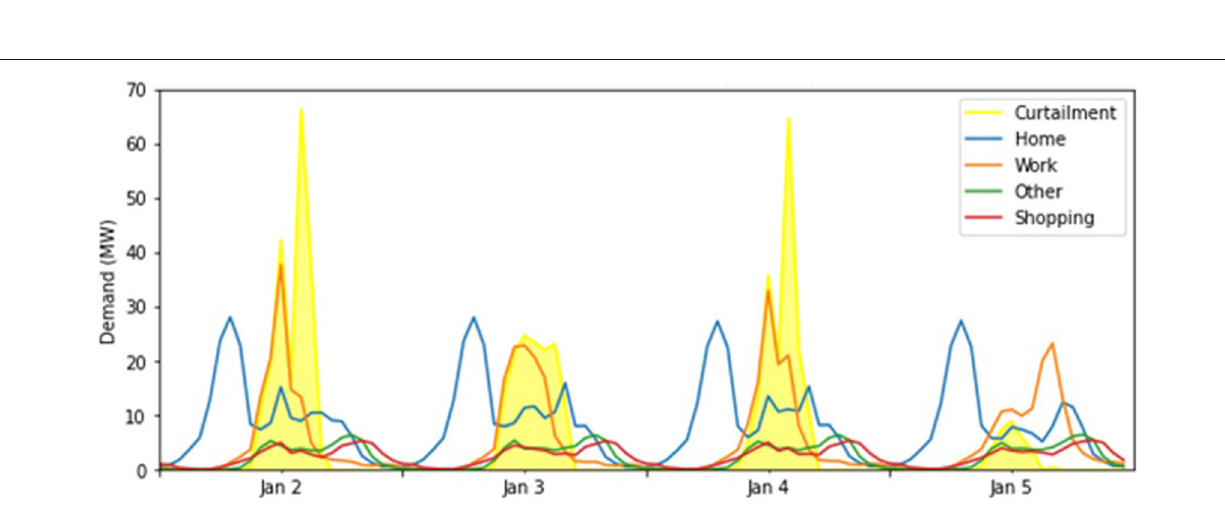
Frontiers in Sustainable Cities |